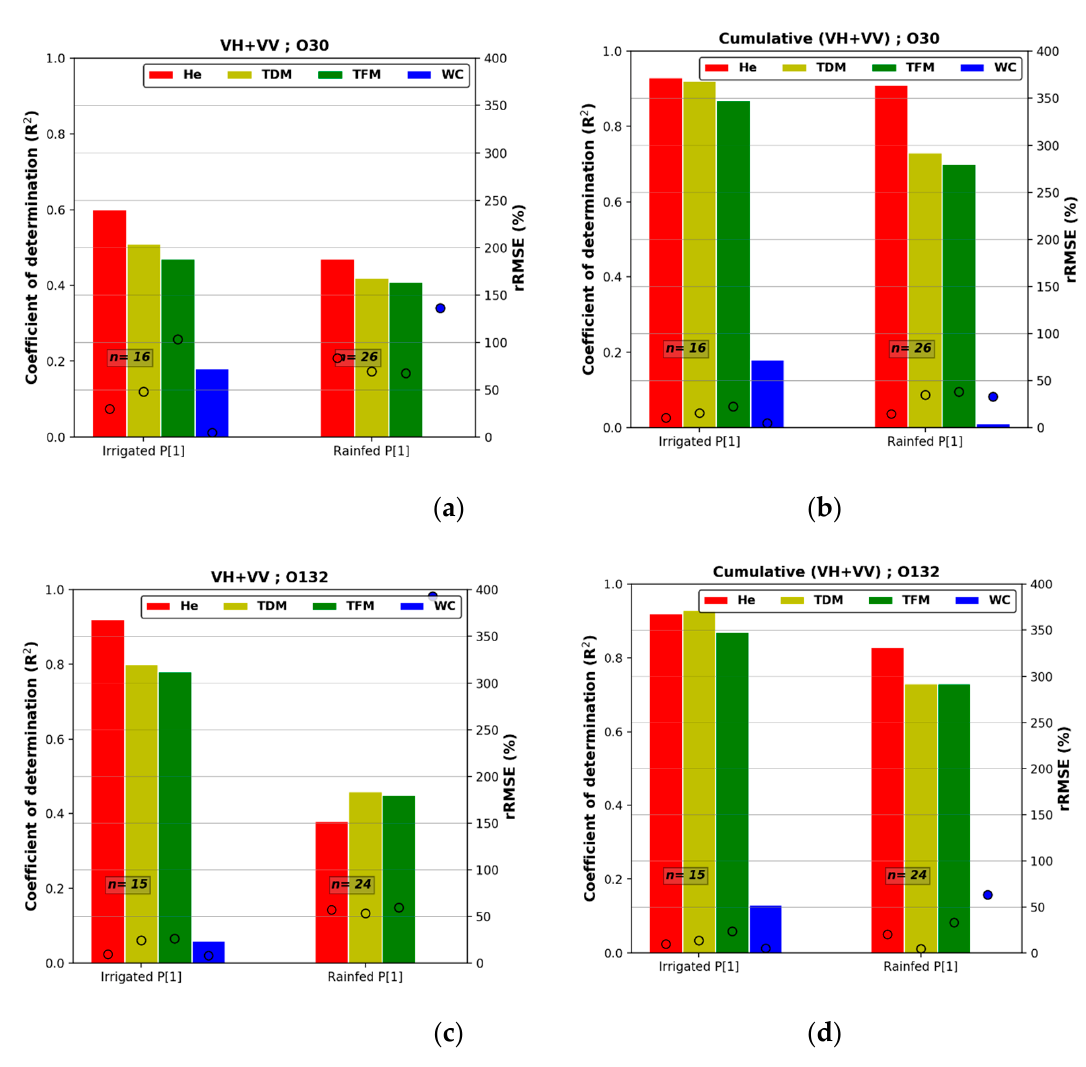
Figure 10. Correlations of the VH + VV ( a ) and ( b ) and its cumulative values ( c ) and ( d ) during the first vegetative period P [1] for orbit 30 and 132 respectively: Impact of phenological stages. Colored circles represent rRMSE values.